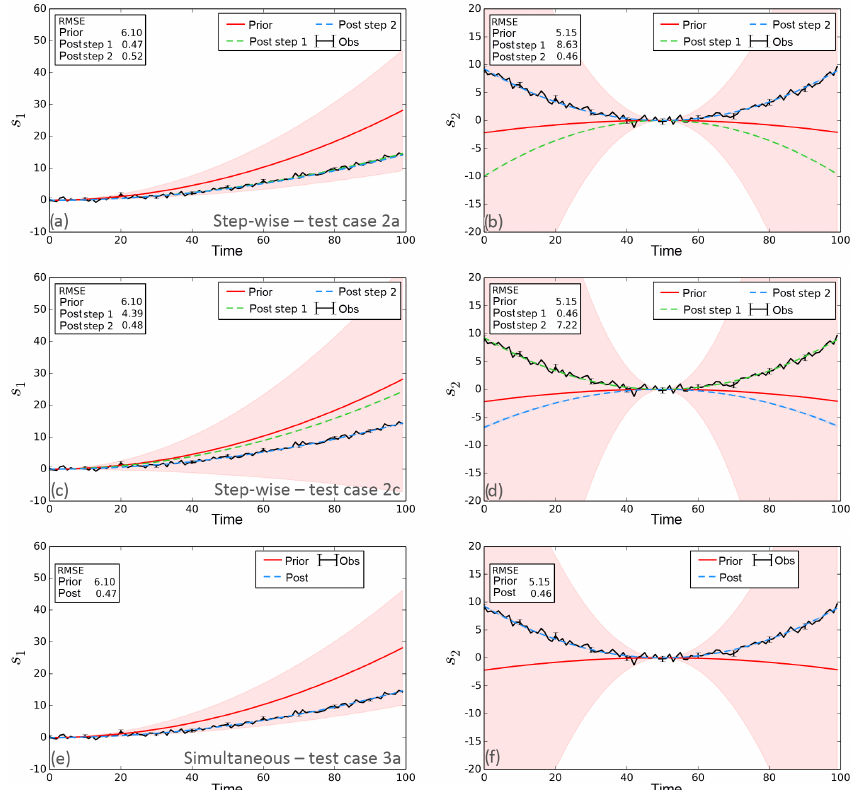
Figure 5. Prior and posterior model simulations compared to the synthetic observations for the non-linear toy model (with no bias) for both the s 1 (left column) and s 2 (right column) variables for (a) and (b) test case 2a (first row) – step-wise approach with s 1 observations assimilated in the first step, followed by the s 2 observations in the second step; (c, d) test case 2c (second row) – step-wise approach with s 2 observations assimilated in the first step, followed by s 1 observations in the second step; and (e, f) test case 3a (third row) – the simultaneous case in which both data streams were included. For both step-wise examples A 1 was propagated between the first and second steps. The coloured error band on the prior and posterior represents the propagated parameter uncertainty (1 σ ) on the model state variables (in the equivalent colour as the mean curve). This is mostly visible for the prior model simulation (pink band) as there is a high reduction in model uncertainty reduction as a result of the